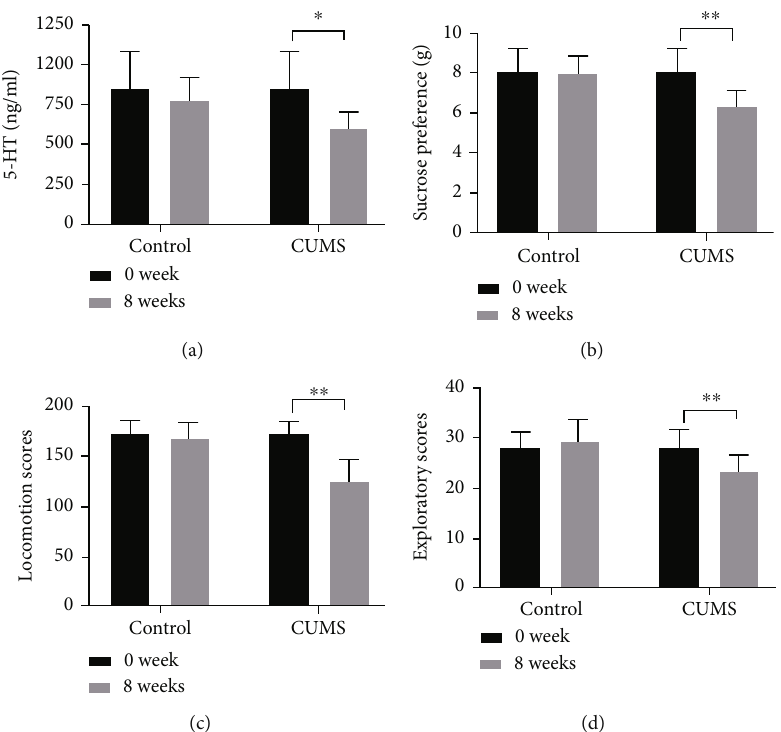
Figure 2: (a) 5-HT level, (b) sucrose preference, (c – d) locomotion scores, and exploratory scores in control and CUMS groups. Data are mean ± SD ( n = 8/group ). ∗ P < 0 : 05and ∗∗ P < 0 : 01